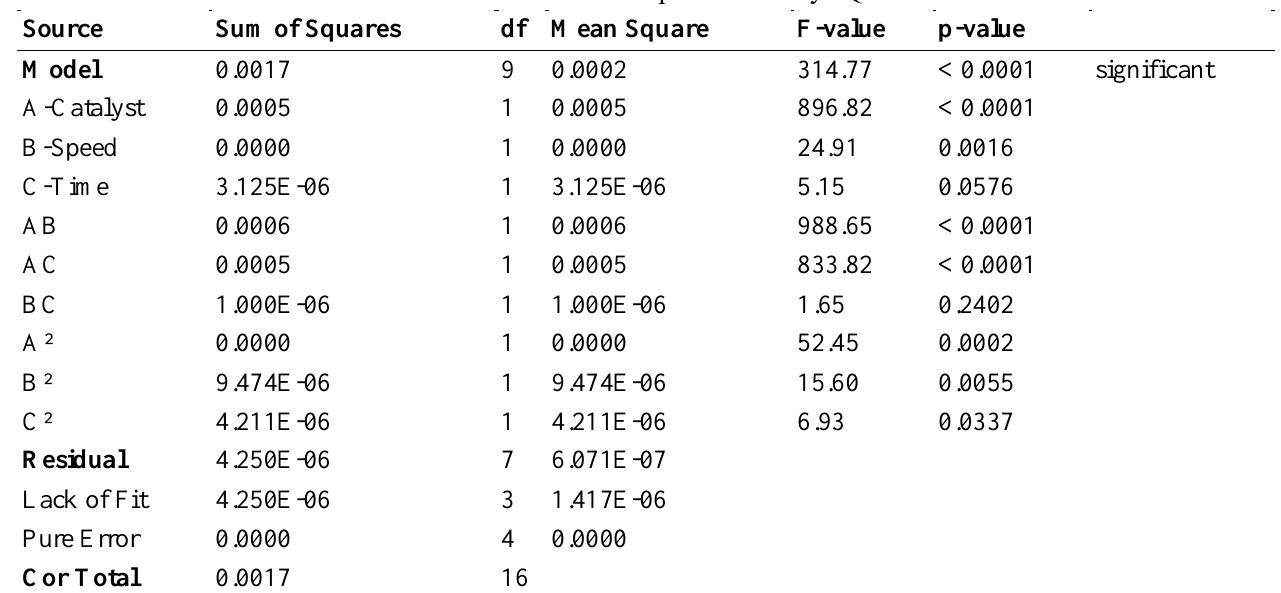
Table 10: ANOVA Table for the “Specific Gravity” Quadratic model.